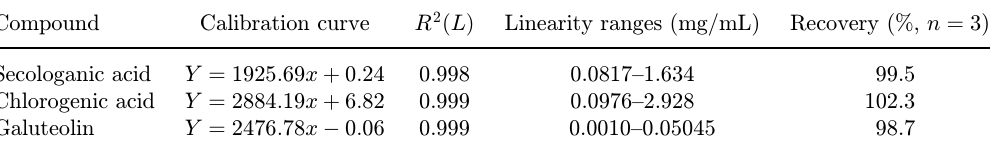
Table 2. Calibration curves and methodology parameters of the reference method.